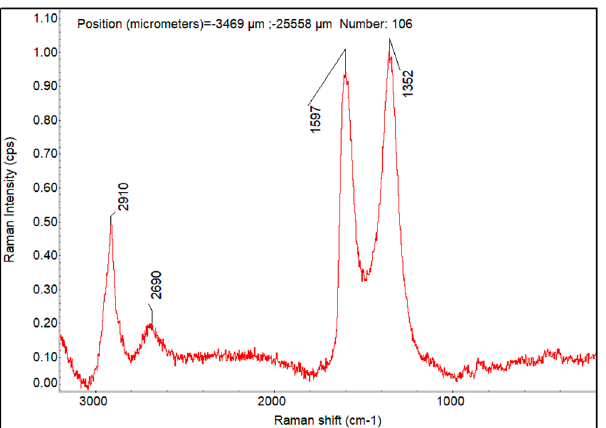
Figure 8. Raman images obtained using peak height profiling option of normalized Raman spectra for the PVA_GO_CNT_COOH membrane in a region of 65 um × 65 um. These images are the peak height distribution for ( a ) PVA, ( b ) CNT_COOH, ( c ) GO_CNT-COOH, and ( d ) GO_CNT_COOH in the composite hybrid membrane.